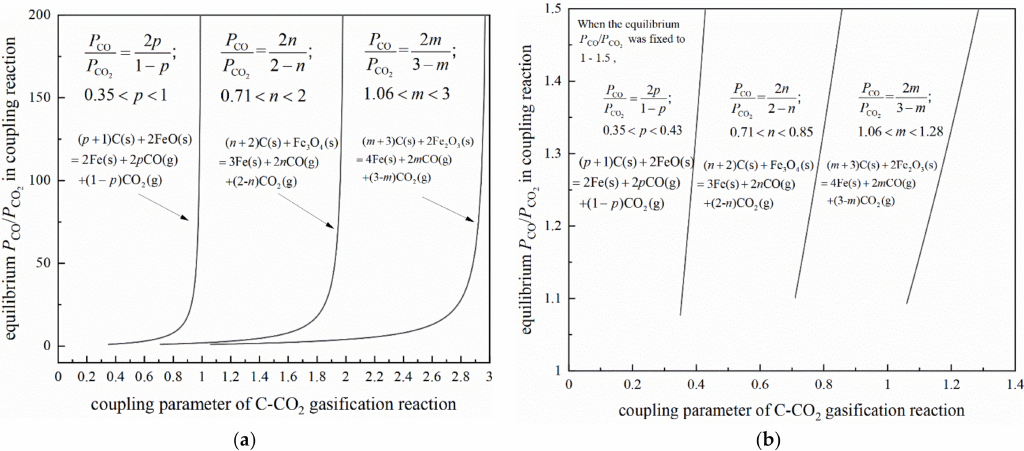
Figure 13. The ratio of equilibrium gas partial pressure of CO and CO 2 as a function of coupling parameter: ( a ) global; ( b )